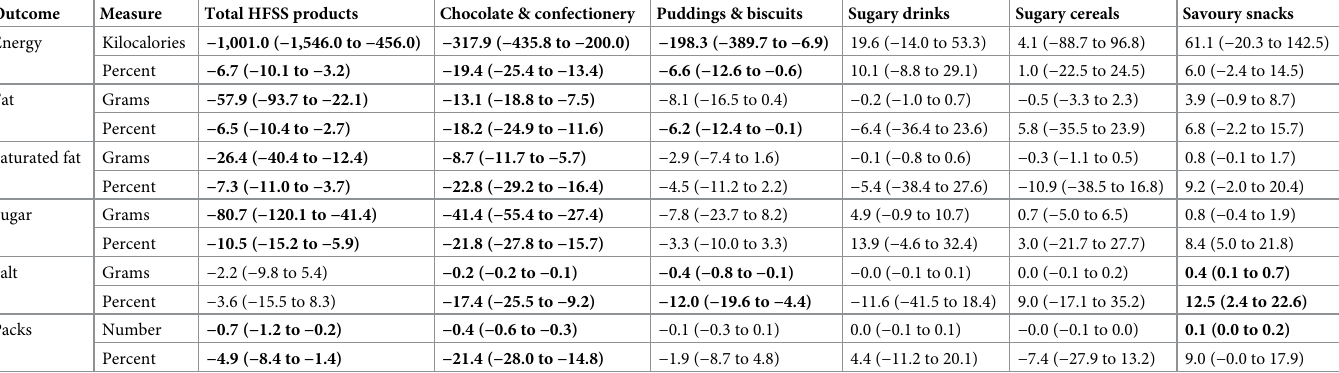
Table 3. Changes and percentage changes in weekly household mean (95% CI) energy and nutrients purchased from high fat, salt, and sugar (HFSS) products and packs of HFSS products purchased, in London (intervention group) compared to the counterfactual, 18 June 2018 to 29 December 2019 ( n =